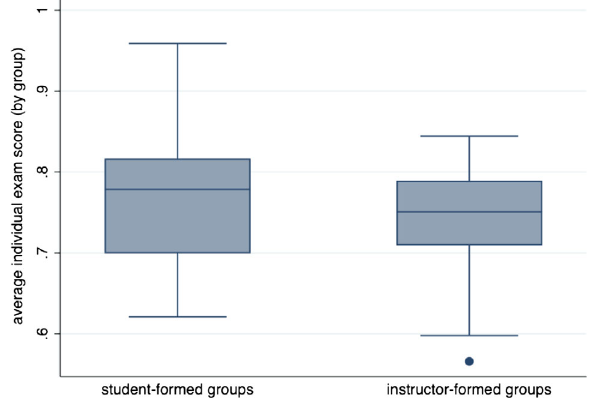
FIG. 5. Box and whisker plot depicting median, max, and min of individuals ’ scores on student-formed groups and instructor- formed